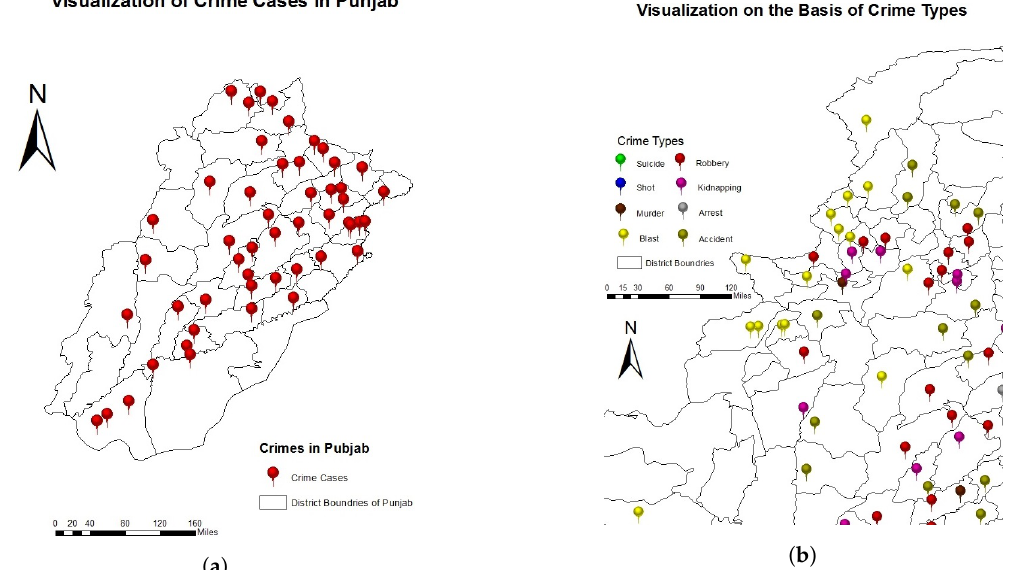
Figure 2. Visualization of ( a ) crime cases and ( b ) crime types during last eight years using ArcGIS.